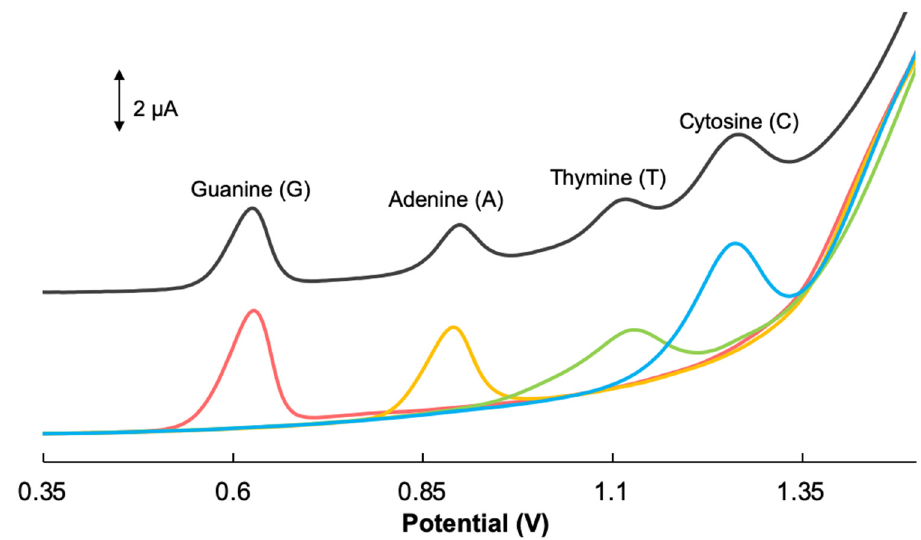
Figure 4. Differential pulse voltammograms of GCE/GONRs-CH (60 μ M, red line), G (12 μ M, orange line), A (12 μ M, yellow line), T (170 μ M, green line) and C (170 μ M, blue line) individually and in the mixture (black line) in 0.1 M PBS (pH 7.0).